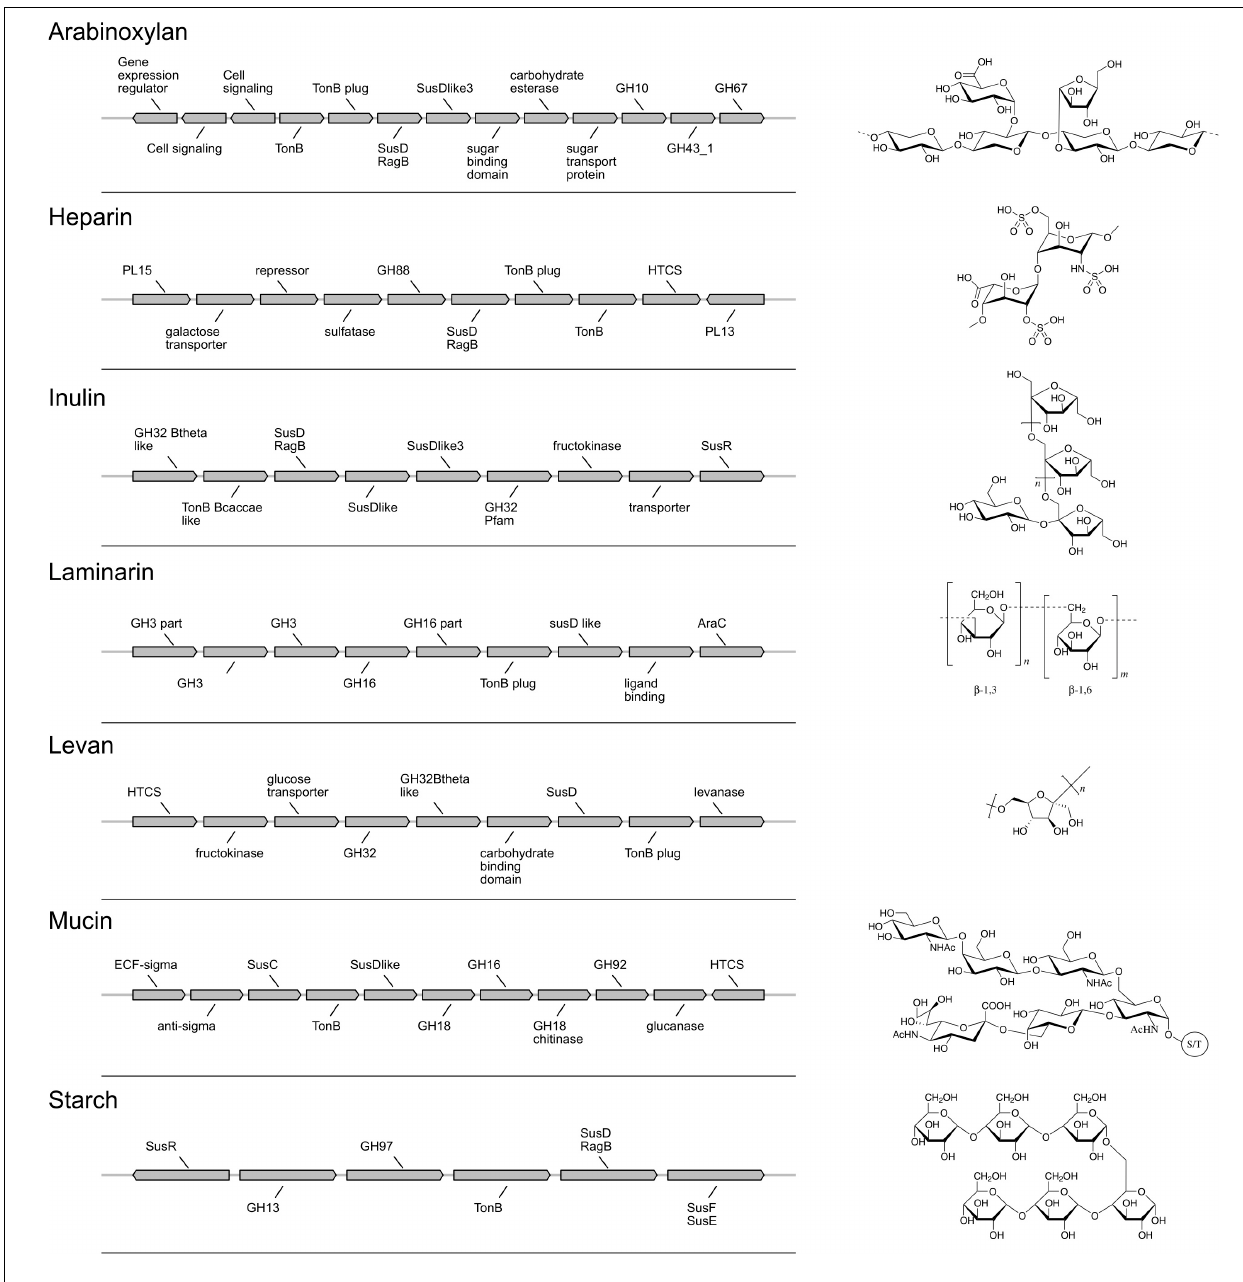
FIGURE 3 | Polysaccharide utilization loci (PUL) gene models and fiber structures. Gene annotations and organization of each PUL model are shown on the left. Chemical structures of the associated fibers are drawn on the